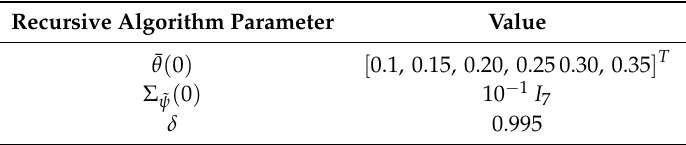
Table 3. Initialization parameters of the adaptive